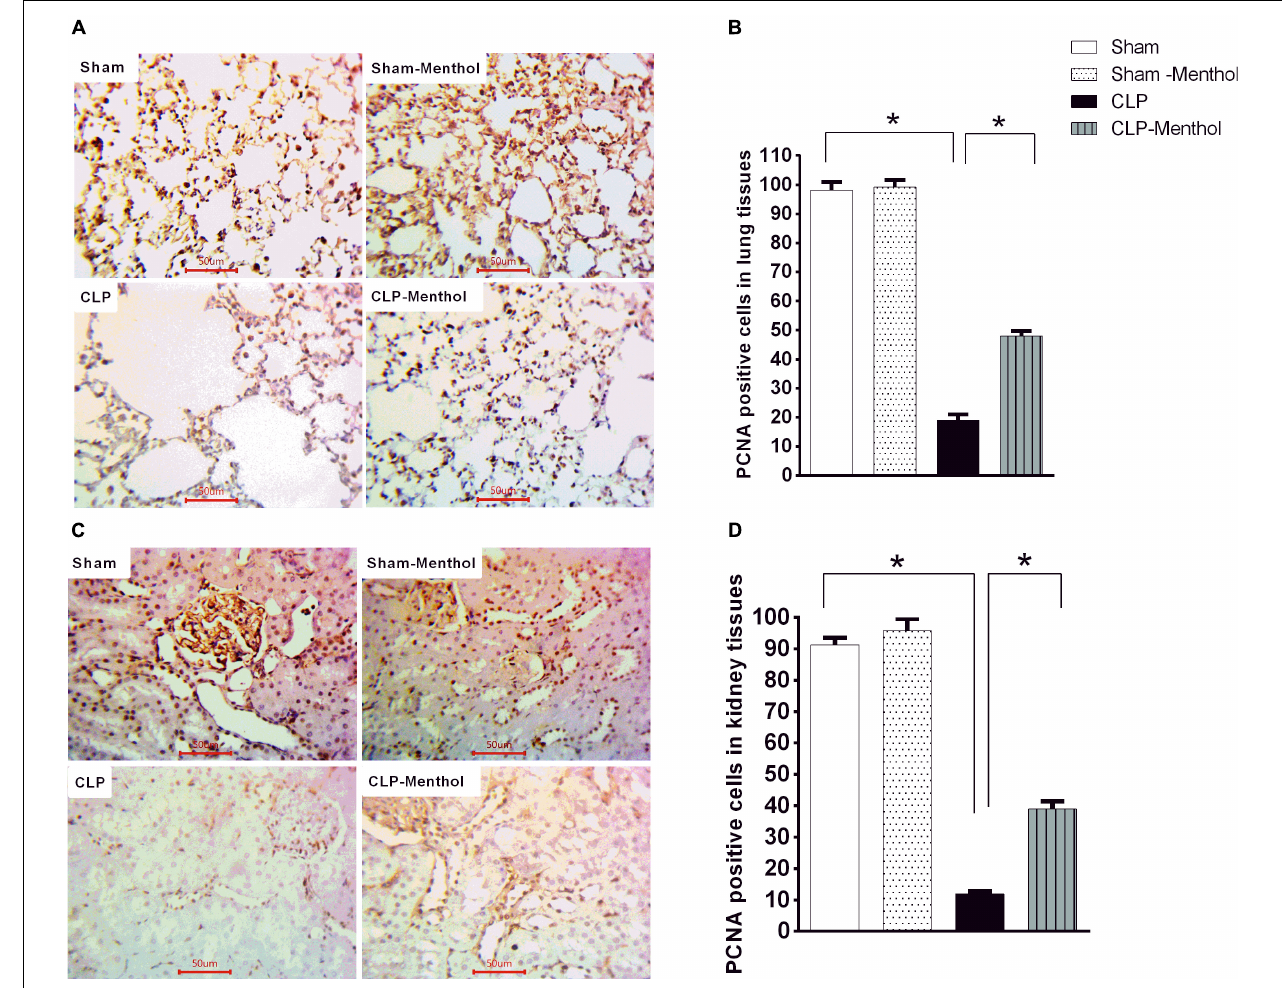
FIGURE 9 | Menthol attenuates sepsis-induced reduction of PCNA expression in lung and kidney tissues. Determination of the tissue levels of PCNA was carried out by immunohistochemical staining of paraffin-embedded lung (A) and kidney (C) sections, as described in the “Materials and Methods” section. Mouse monoclonal anti-PCNA (cat. # ab29, Abcam, Cambridge, United Kingdom) was used in this experiment. Images of 10 random fields per slide from each group ( n = 6) were selected and the mean surface area fraction of PCNA immuno-positive cells was measured using ImageJ software. Representative photomicrographs (A) showing PCNA immunoreactivity in lung tissues, and the Bar charts (B) show a semi-quantitative analysis of the data from all groups. Photomicrographs showing PCNA immunoreactivity in the kidney sections are shown (C) , which are semi-quantitatively analyzed in (D) . Data in the bar charts represent the mean ± SEM of 6 independent observations. Data were analyzed by one-way ANOVA followed by the Tukey-Kramer post- test for multiple comparisons. *Significantly different at p < 0.05 compared to the CLP